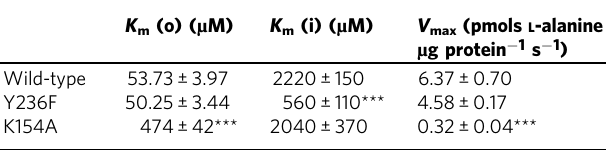
Fig. 1 Crystal structures of BasC. a , b Crystal structure of BasC apo in complex with nanobody 74 (Nb74) at 2.9 Å (PDB ID 6F2G). Helices are colored blue to red from the N-termini and Nb74 is shown in magenta. c , d Crystal structure of BasC-Nb74 in complex with 2-AIB at 3.4 Å (PDB ID 6F2W). Helices are colored as in a , b , and the protein surface is depicted in light gray. The sagittal plane shows the substrate 2-AIB (orange) at the end of the vestibule open to the cytoplasm. d Detail of region squared in c showing the residues in the thick barrier that prevents the substrate from accessing the extracellular medium Table 1 Kinetic parameters for L -alanine in BasC wild-type and